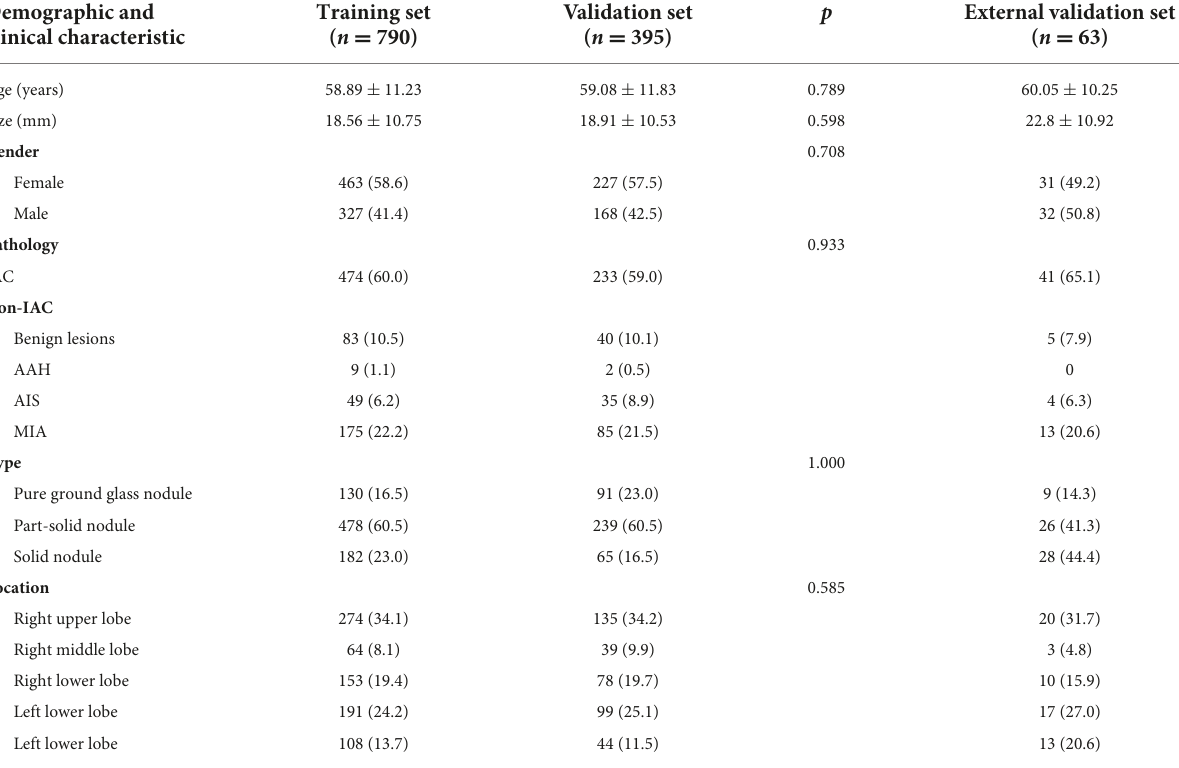
TABLE 2 Patient information of the training set, validation set and external